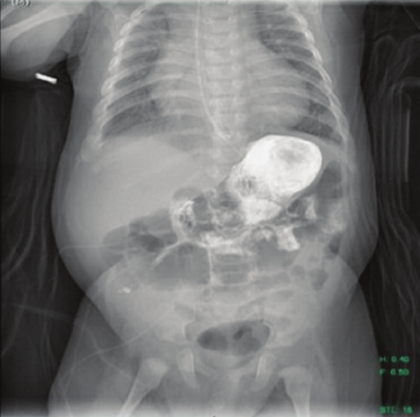
Figure 2: Resolution of the ovoid filling defect on a subsequent upper gastrointestinal fluoroscopic series after treatment with N-